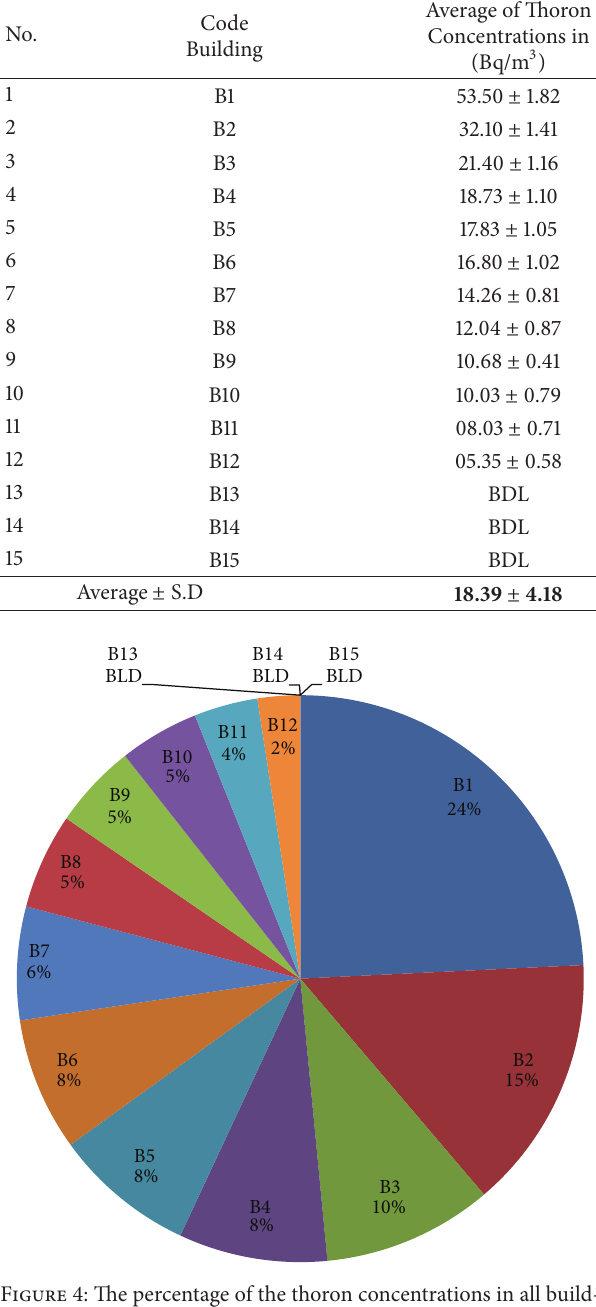
Figure 4: The percentage of the thoron concentrations in all build- ings of Kufa Technical Institute.